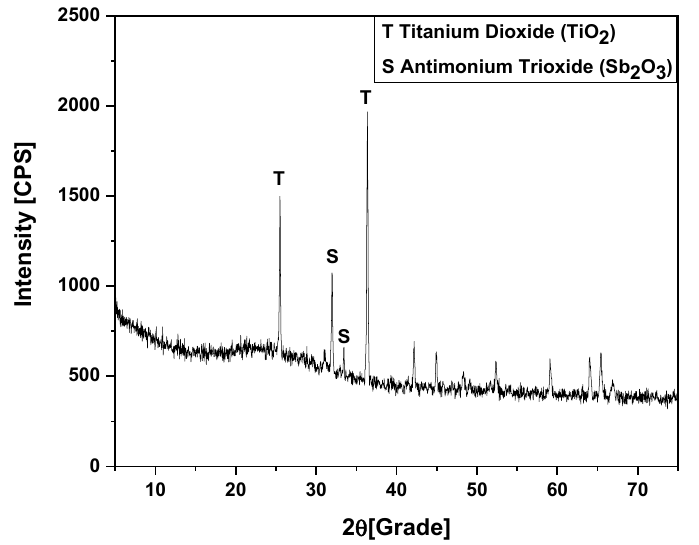
Figure 13. XRD analysis of char obtained through thermal cracking experiments at 450 °C of WEEE plastic.